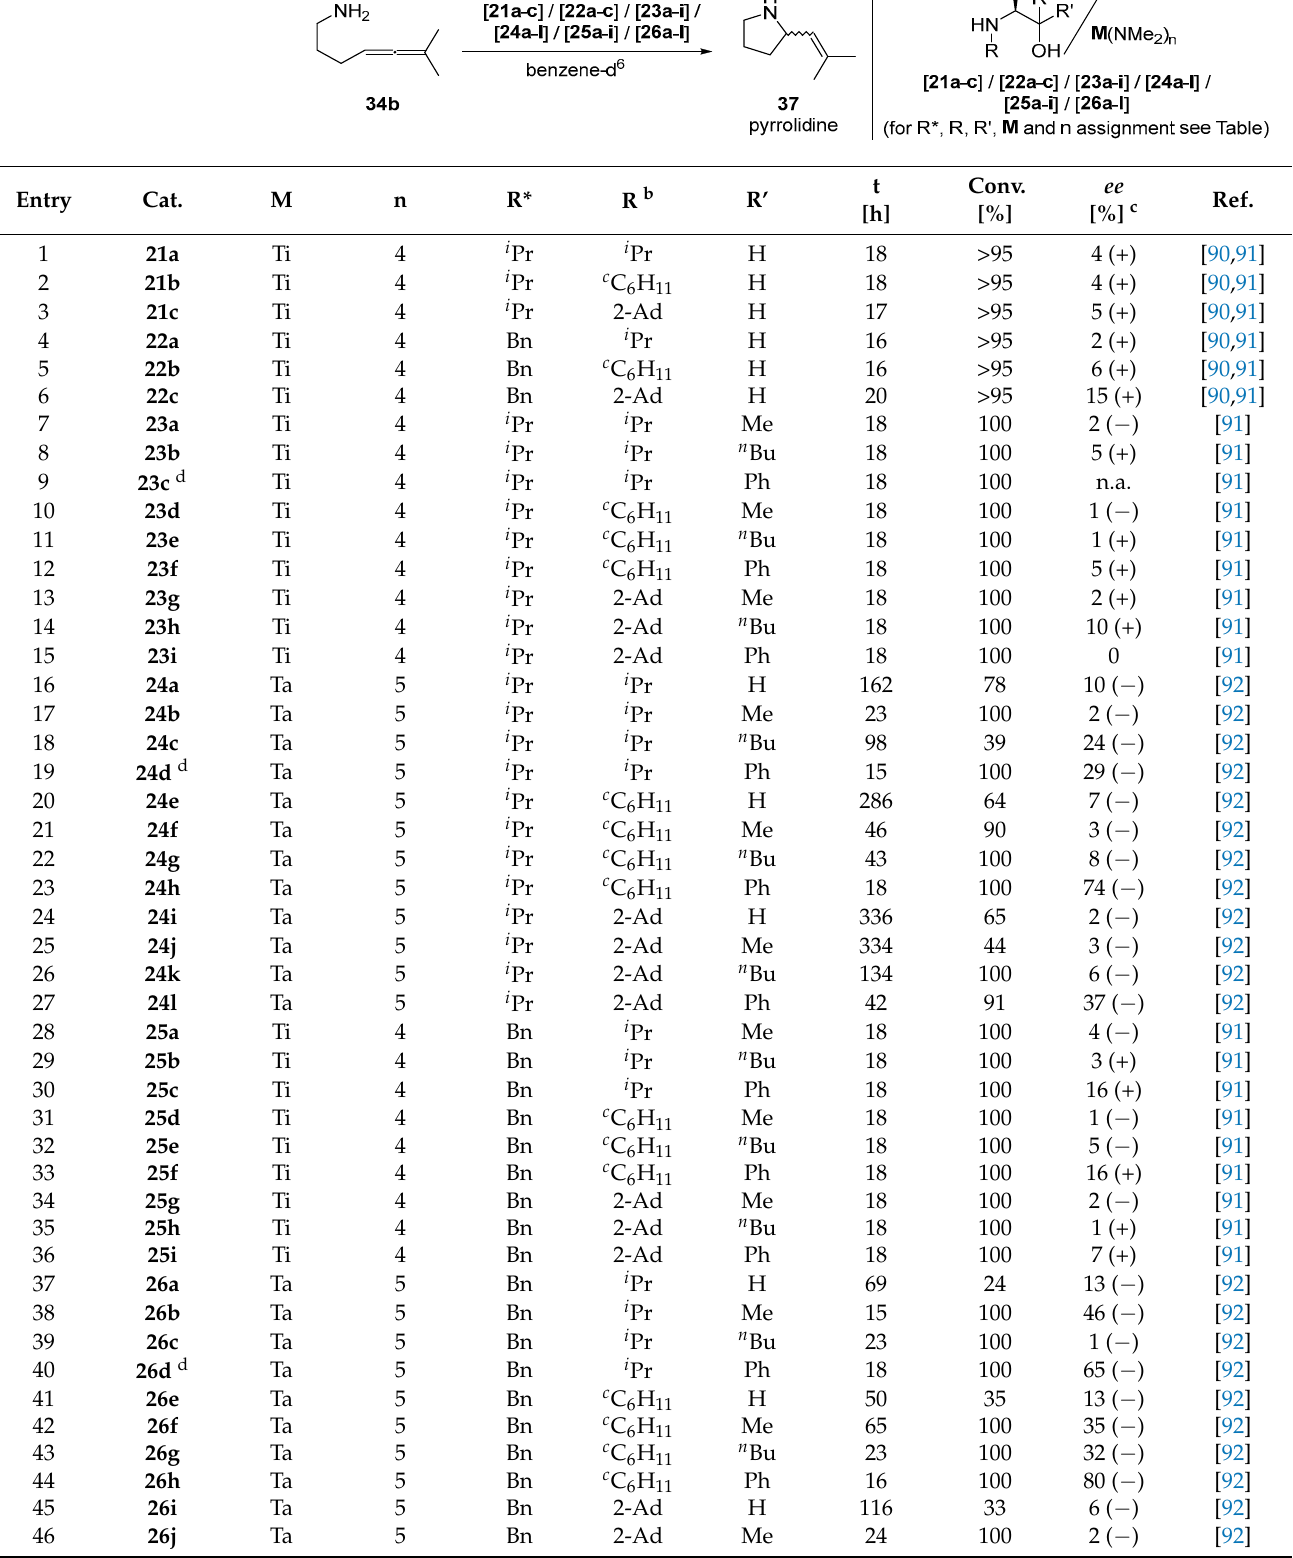
Table 6. Catalytic asymmetric hydroamination of 34b using chiral titanium 21a – c , 22a – c , 23a – i and